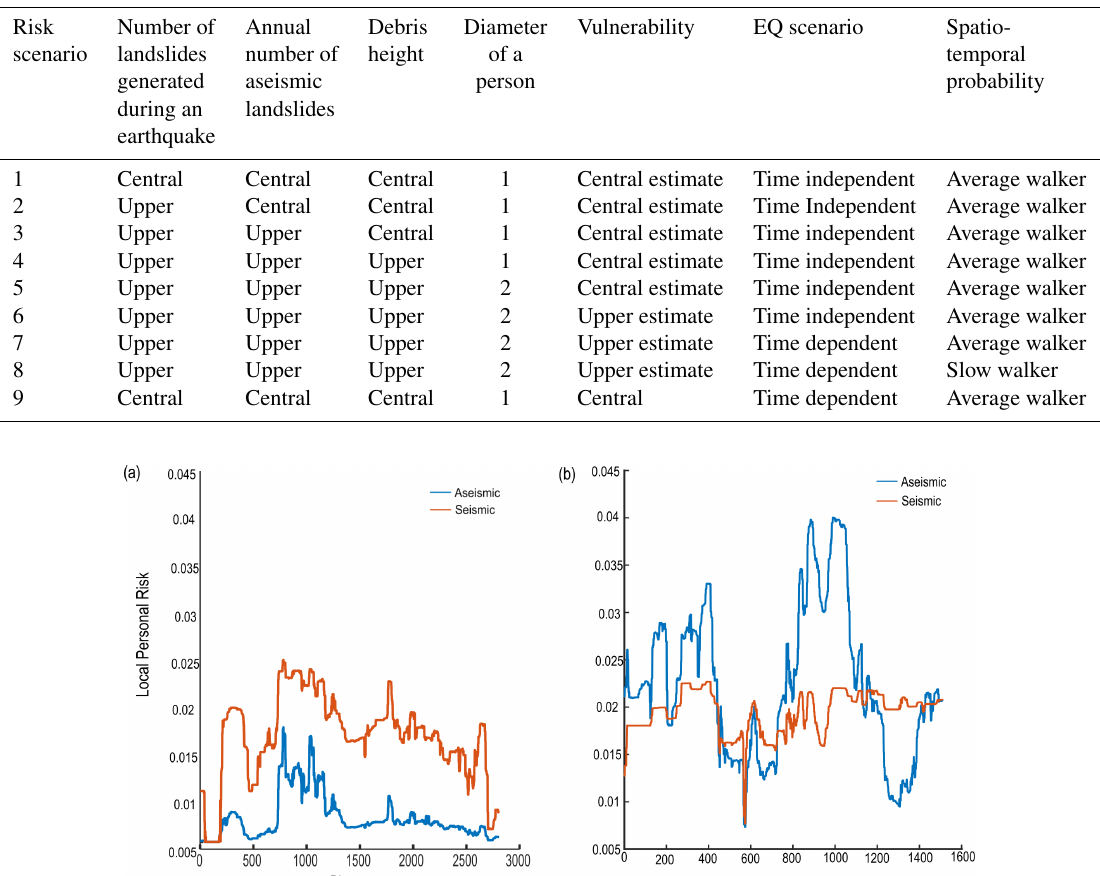
Figure 9. Risk results for Scenario 9 (central estimate and time-dependent earthquake frequency) along the access track in the (a) Franz Josef Glacier valley and (b) Fox Glacier valley, displaying the contributions of aseismic landslide risk and seismic landslide